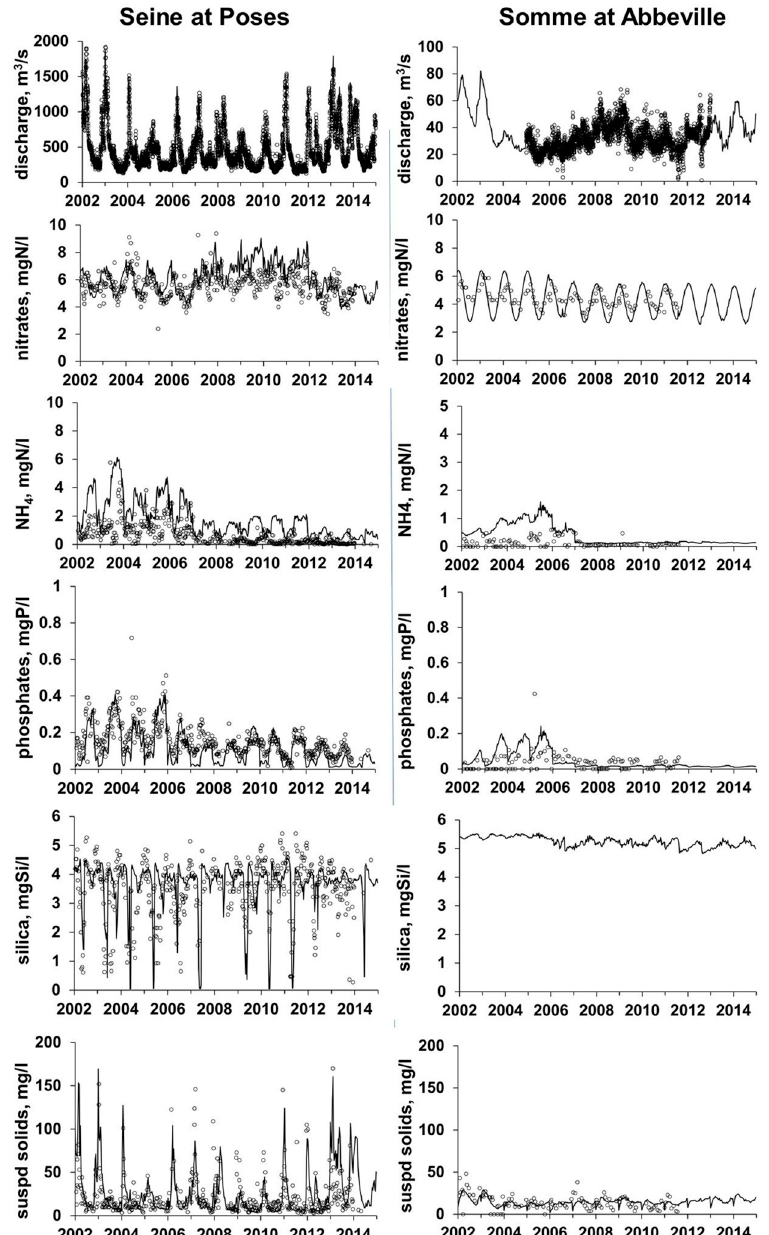
Figure 3. Seasonal and inter-annual variations in water flow and nutrient concentrations for the Seine River at Poses and the Somme at Abbeville; the outlets of the Seine and Somme rivers. Simulations by GRAFS-RIVERSTRAHLER and comparison with observations.